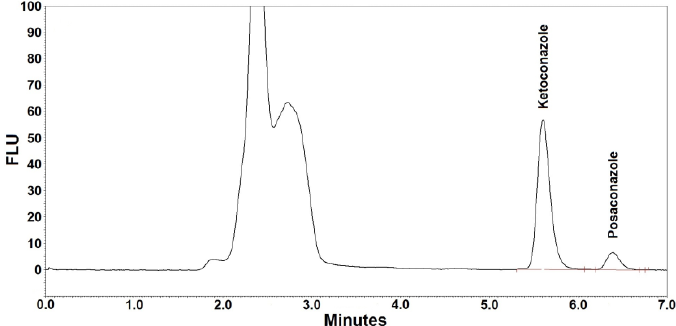
Figure 2. Representative chromatogram (ketoconazole at ~5.6 min, posaconazole at ~6.4 min) after extraction of a patient’s serum. The posaconazole concentration was 0.98 µg/mL.